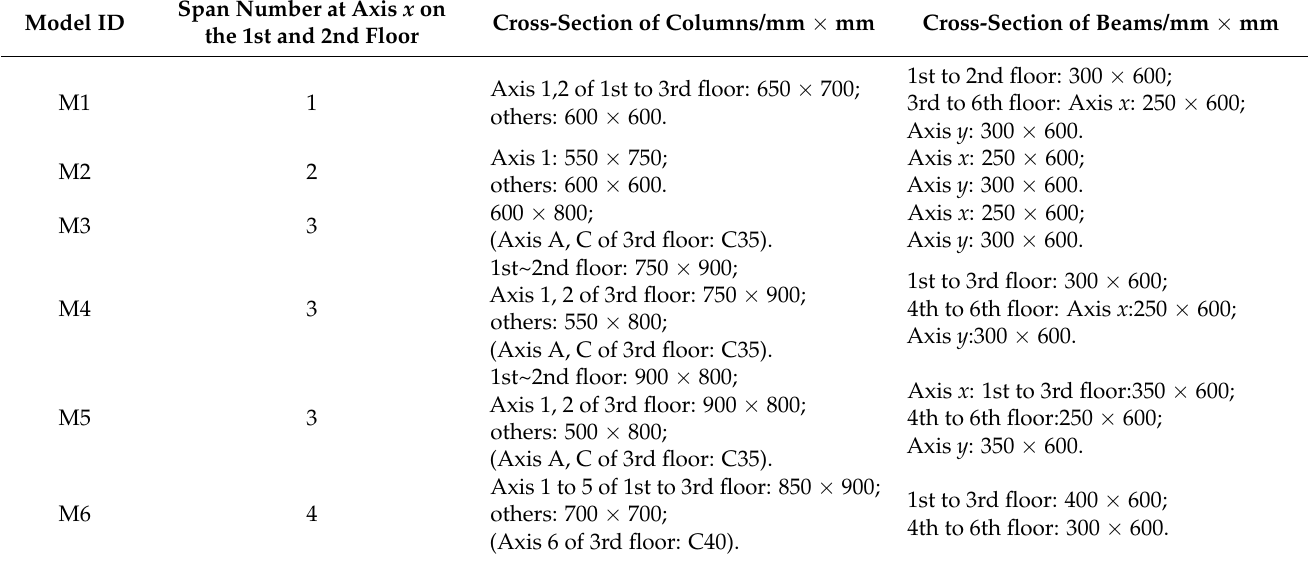
Table 3. The layout of structure